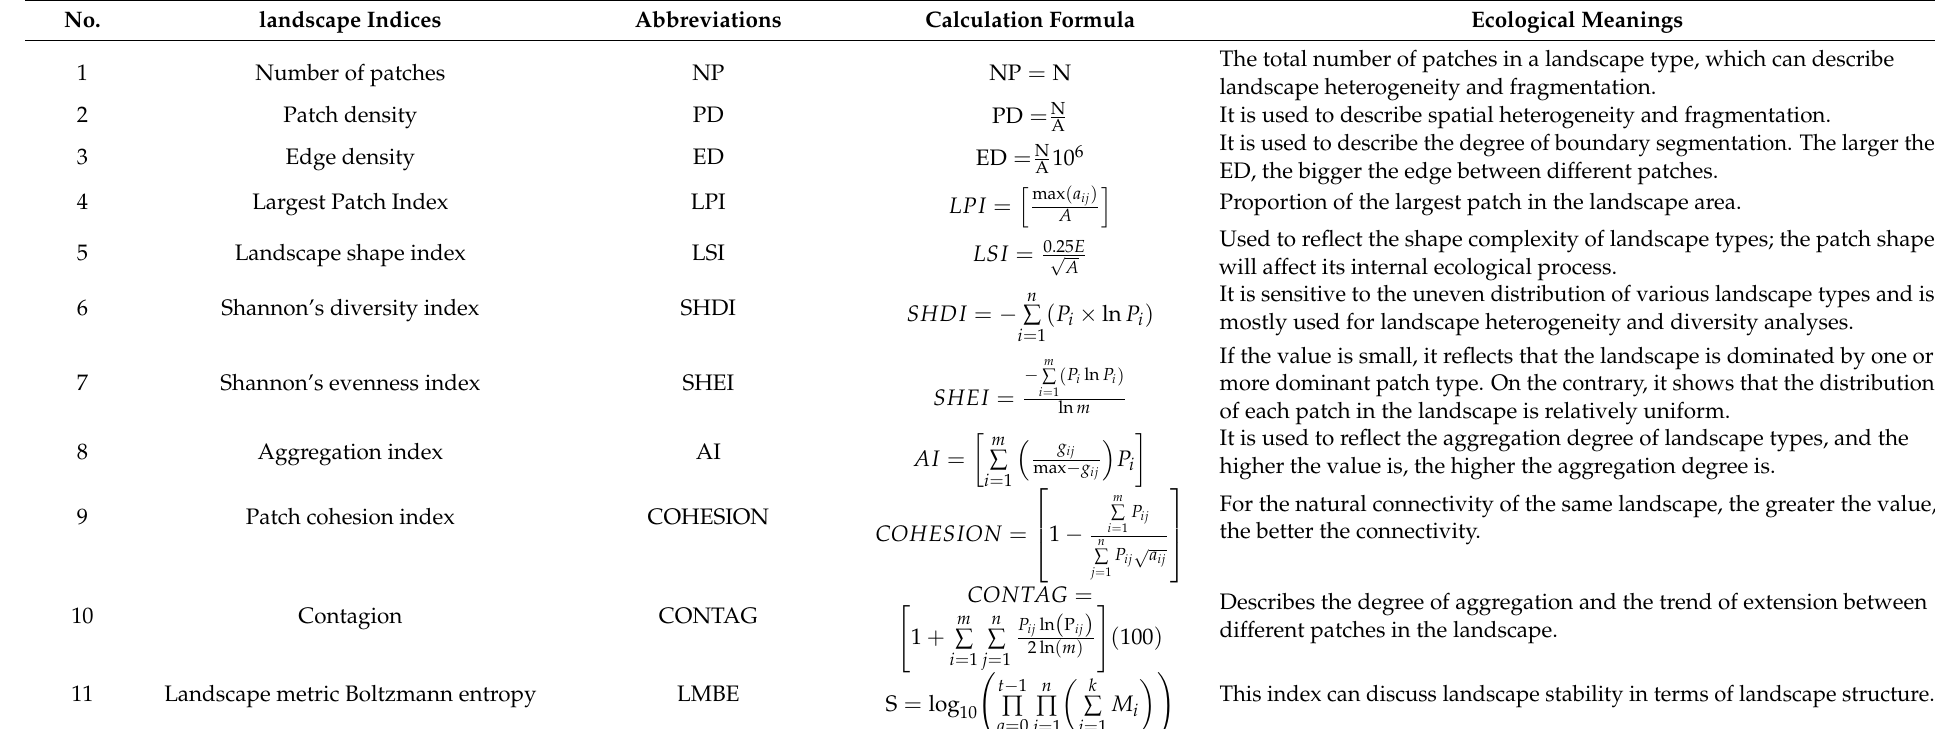
Table 1. Landscape